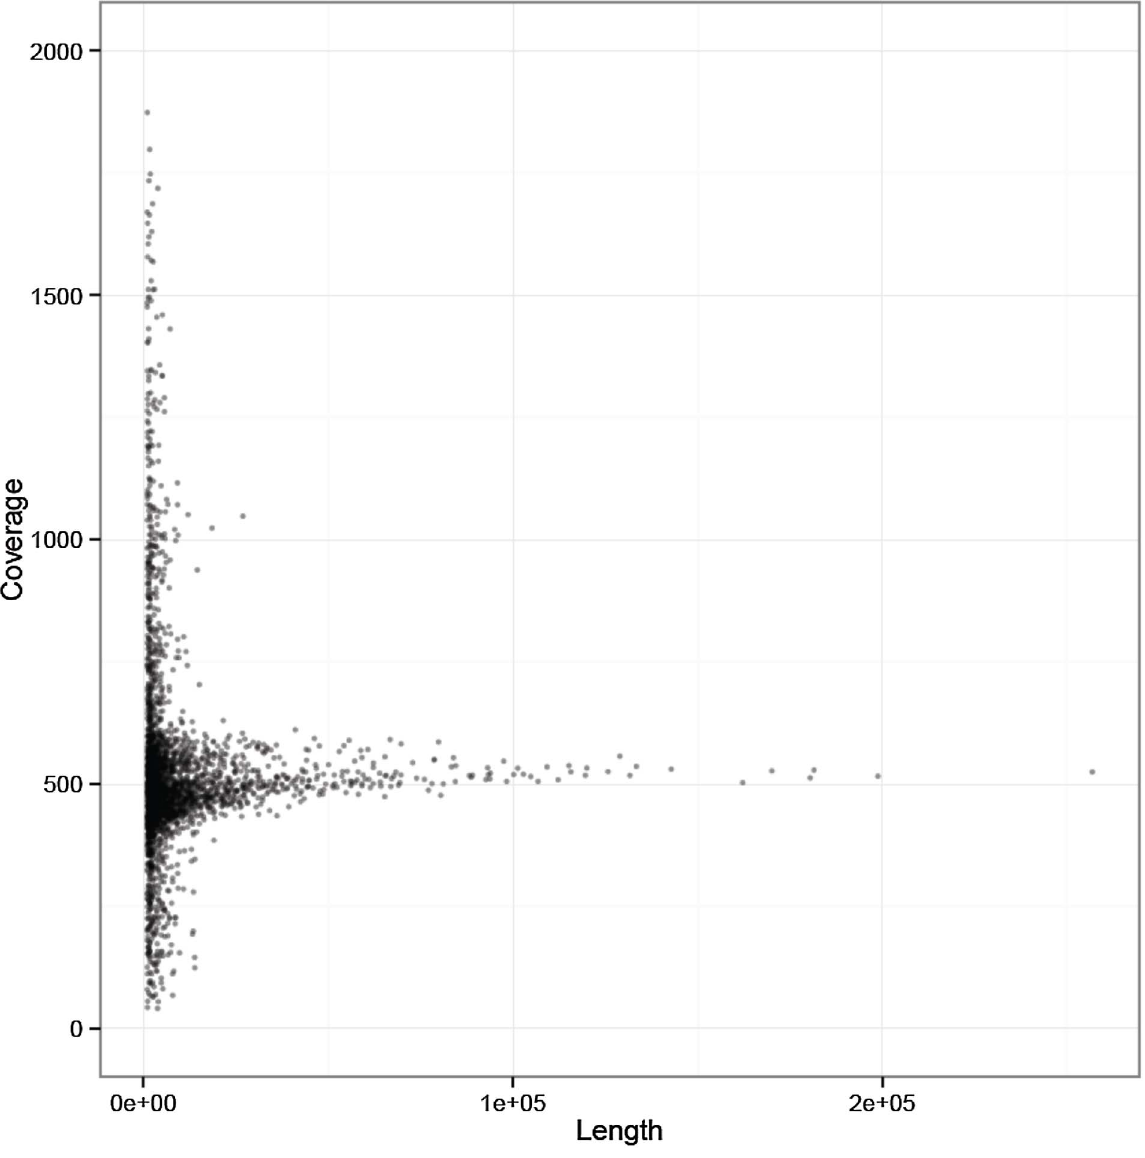
Figure 1. Sequence coverage for all denovo assembled contigs. The figure shows the average sequence coverage (y-axis, in read per base) of each de novo assembled C127 contig according to the contig length (x-axis, in bp). Six short ( , 200 bp) contigs displayed coverage greater than 2,000 reads by base and are not shown on this figure. doi:10.1371/journal.pntd.0002569.g001 PLOS Neglected Tropical Diseases |